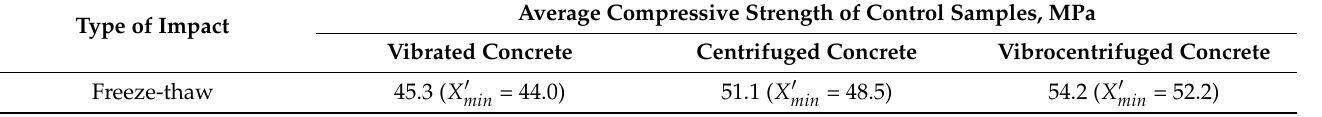
Table 8. Results of tests of control samples.